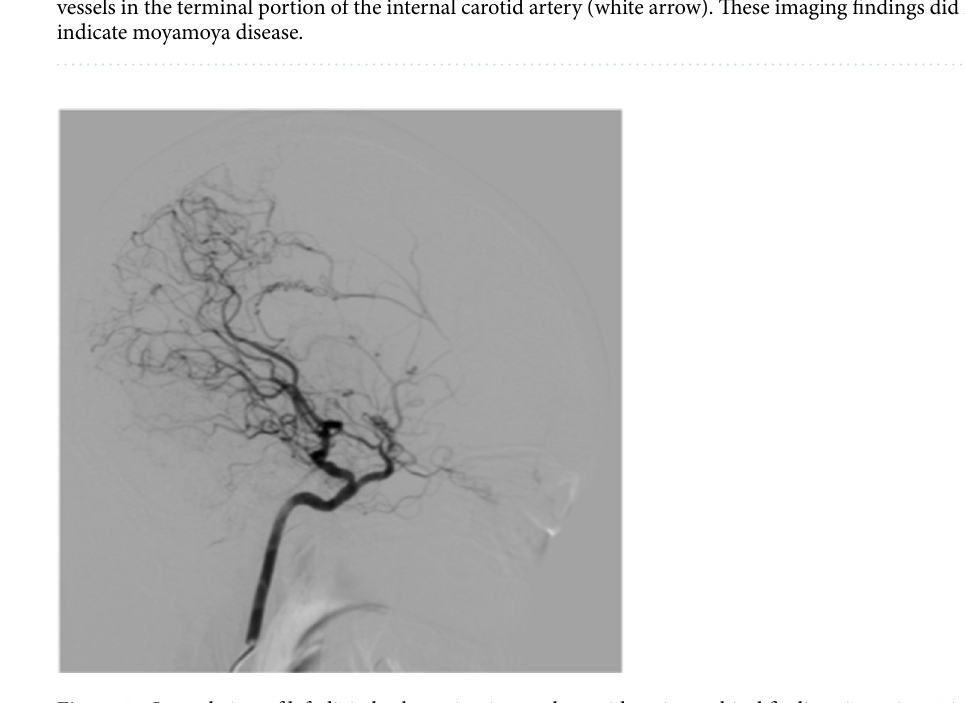
Figure 5. Lateral view of left digital subtraction internal carotid angiographical findings in patient 5 indicating primitive trigeminal artery and right middle cerebral artery